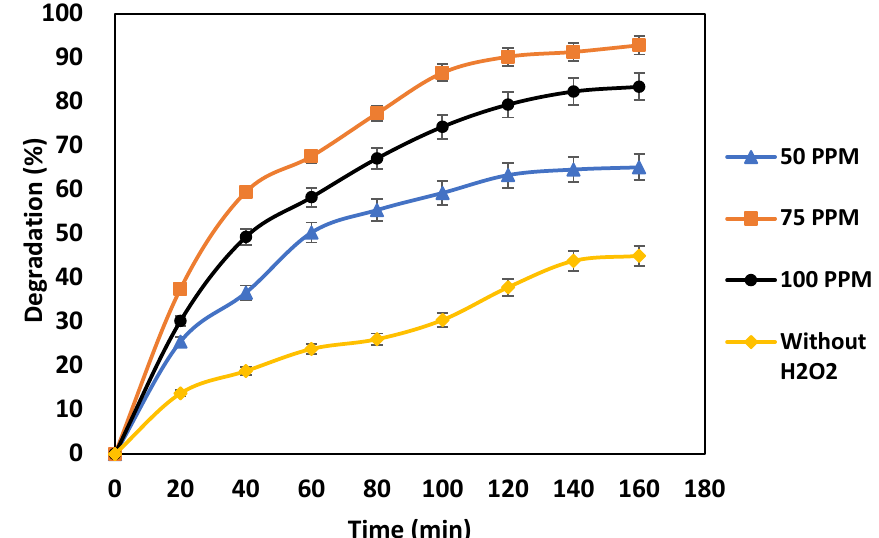
Figure 8. Effect of H 2 O 2 addition on the degradation of Chrysoidine R dye. Without hydrogen peroxide, the degradation observed was around 45%, which sig- nificantly rose to about 65.12% with the use of 50 ppm H 2 O 2 . A further increase in H 2 O 2 loading to 75 ppm resulted in a further increase in the degradation to 92.83%. At 100 ppm loading, however, there was a reduction in the degradation of dye with an actual value of 83.41%, which is about 11% lower compared to 75 ppm loading. As 75 ppm yielded maximum degradation, it was chosen as the optimum. The declining degradation at the highest oxidant loading can be due to residual hydrogen peroxide, which generally acts as a hydroxyl radical scavenger and favors the generation of per-hydroxyl radical, which is known to possess less oxidation potential, resulting in a decrease in dye degradation [38,39]. H 2 O 2 + • OH → H 2 O + •